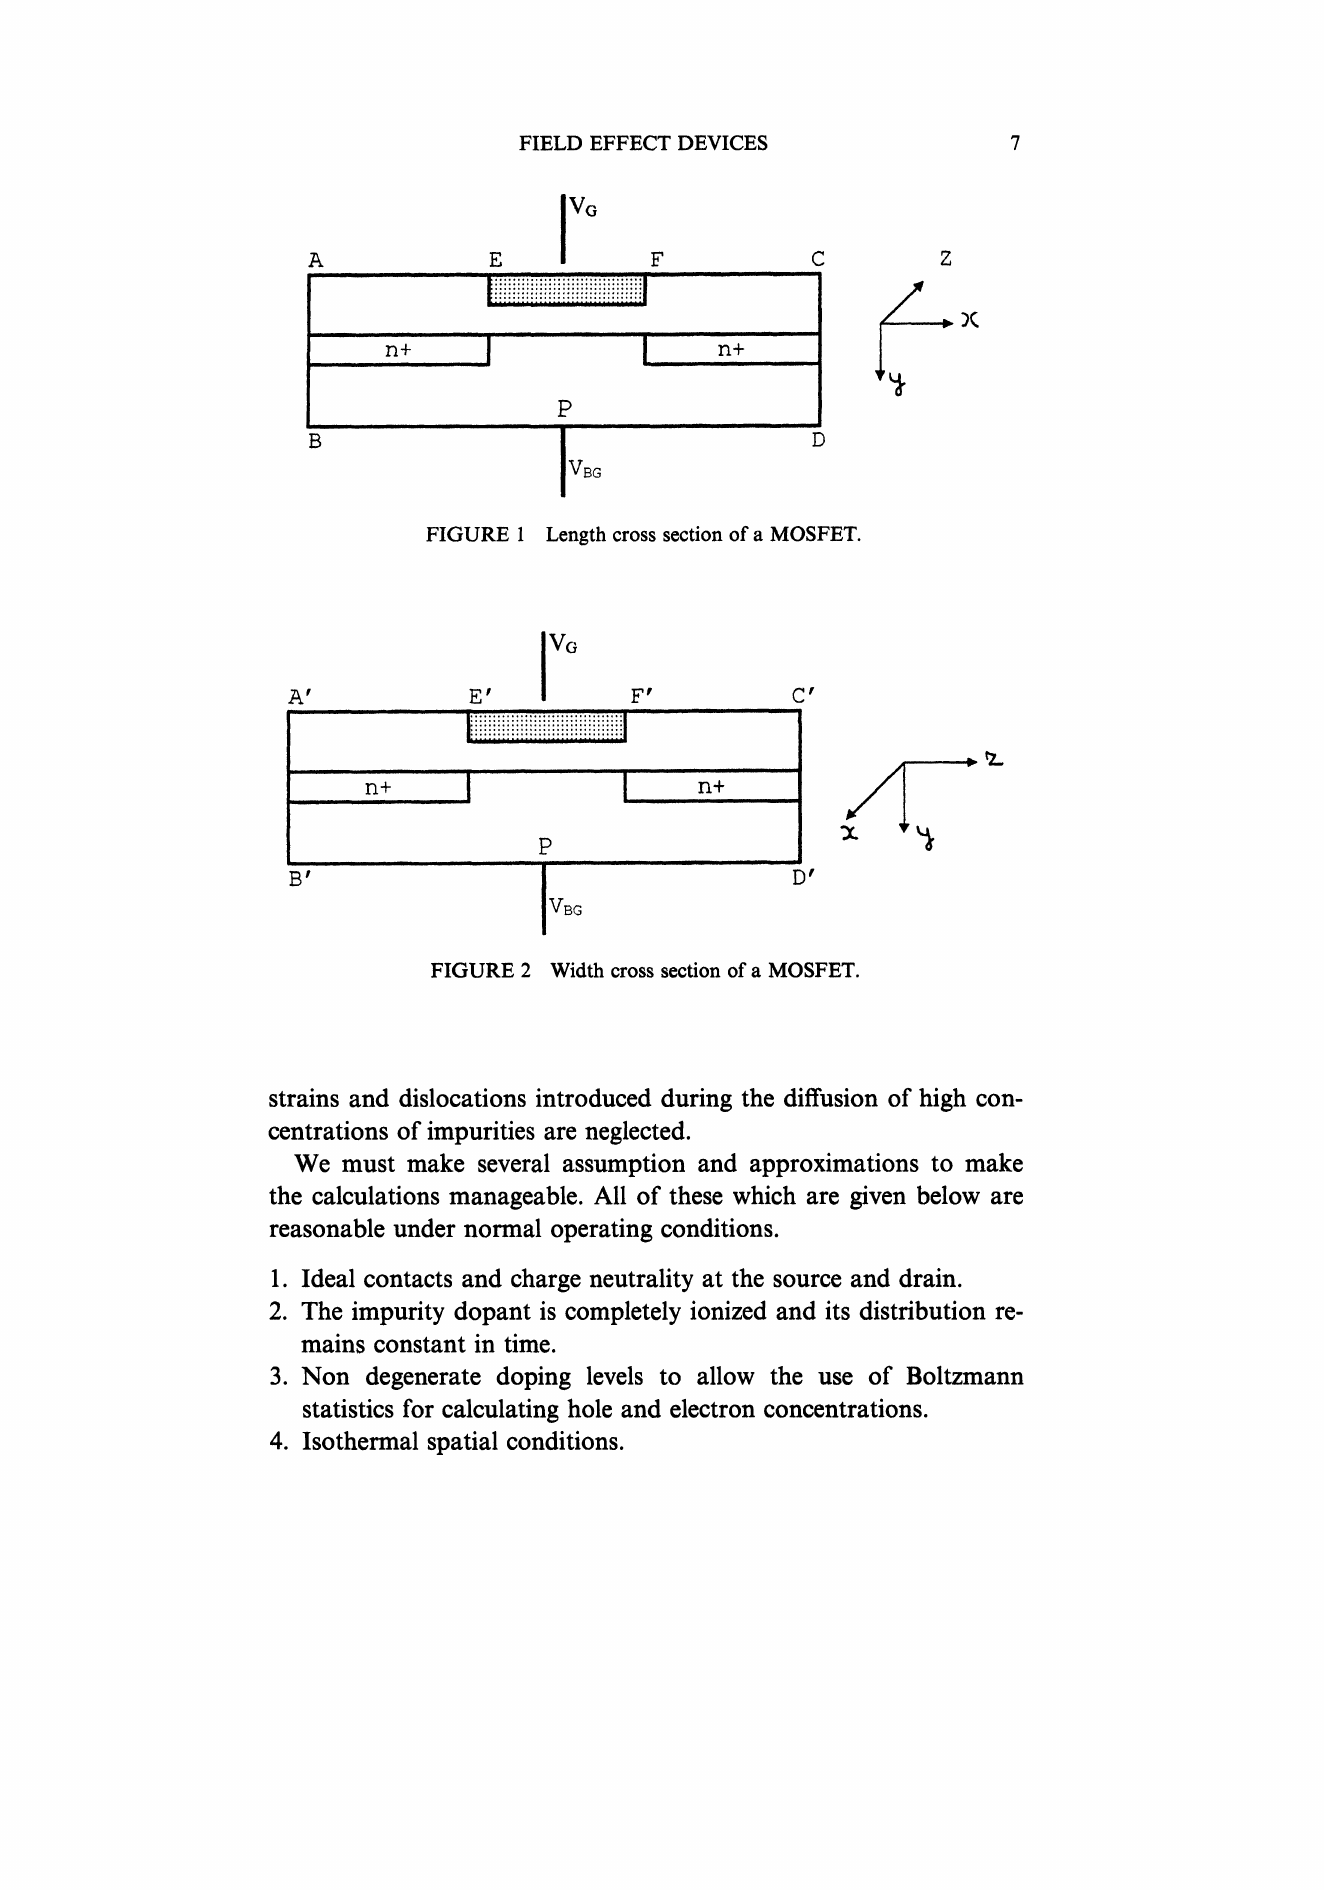
FIGURE 2 Width cross section of a